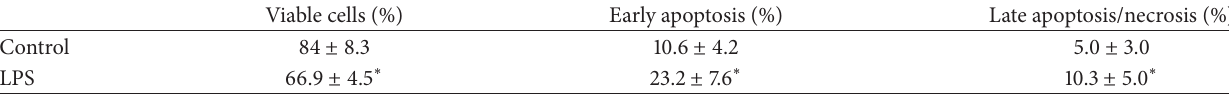
Table 1: N9 microglia exposed to LPS show increased cell death as indicated by Guava Nexin assay.